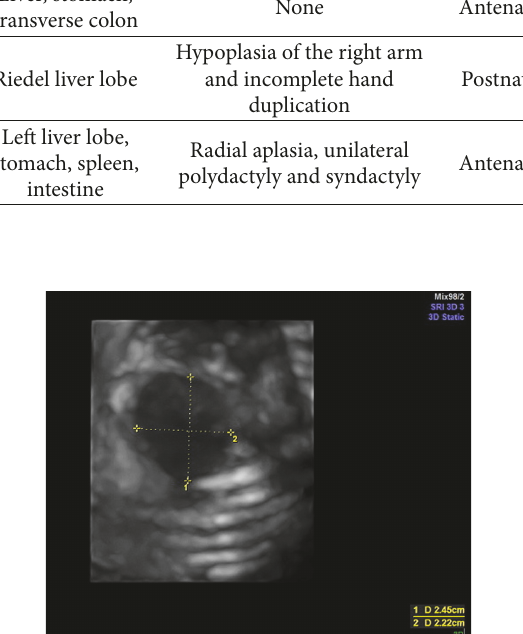
Figure 1: Rib defect on 2D mode (arrow pointing to the 3rd and 4th rib).